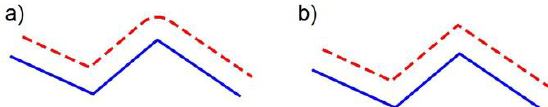
Figure 9. Changing the definition of the boundary. ( a ) Boundary as a broken line parallel to the baseline, distanced by 12 nautical miles at every point; ( b ) Boundary as a broken line parallel to the baseline, distanced by about 12 nautical miles from the baseline. Source: based on [31].